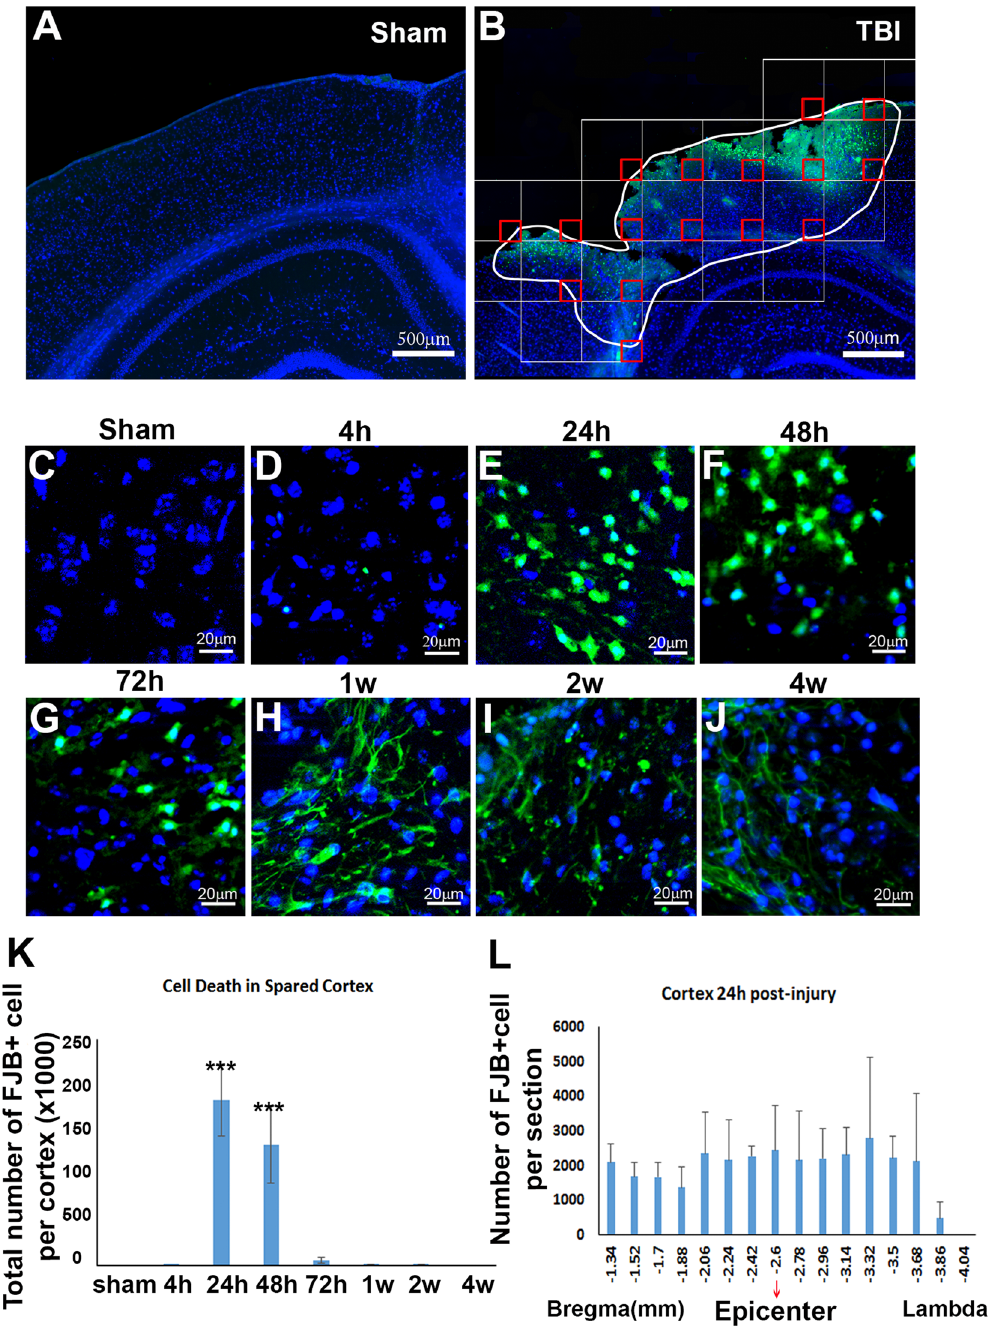
Figure 2. Temporal and spatial patterns of neuronal death in spared cortex after TBI. ( A ) Cortex with sham surgery stained with Fluoro-Jade B. ( B ) Fluoro-Jade B staining (green) showed the neuronal death in cortex after injury and stereological counting. ( C – J ) The temporal pattern of neuronal death in cortex after sham surgery or injury. ( K ) Quantification of FJB stained cells in cortex (n = 4, *** p < 0.001). ( L ) The rostral-caudal distribution of FJB-positive cells in spared cortex at post-injury 24